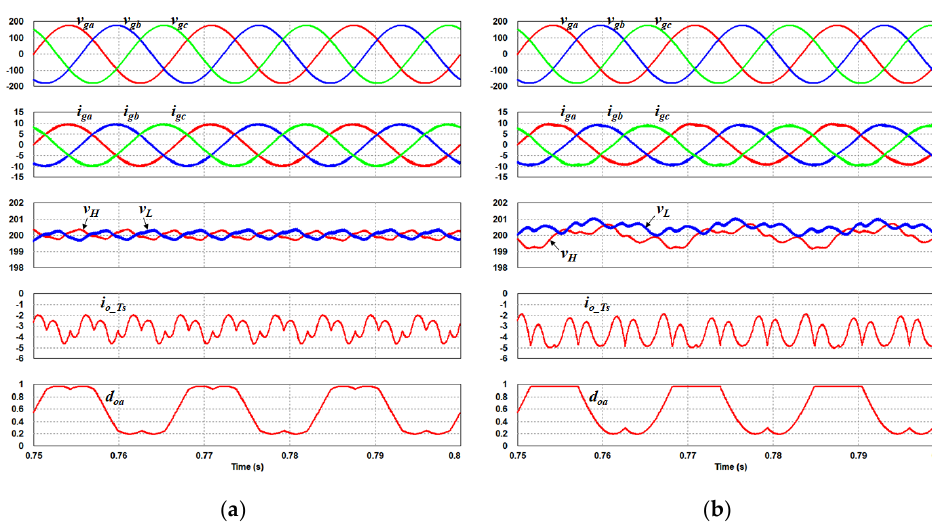
Figure 7. Operational waveforms under unbalanced load condition. ( a ) Output power deviation ( ΔP ): 40% ( b ) Output power deviation ( ΔP ):